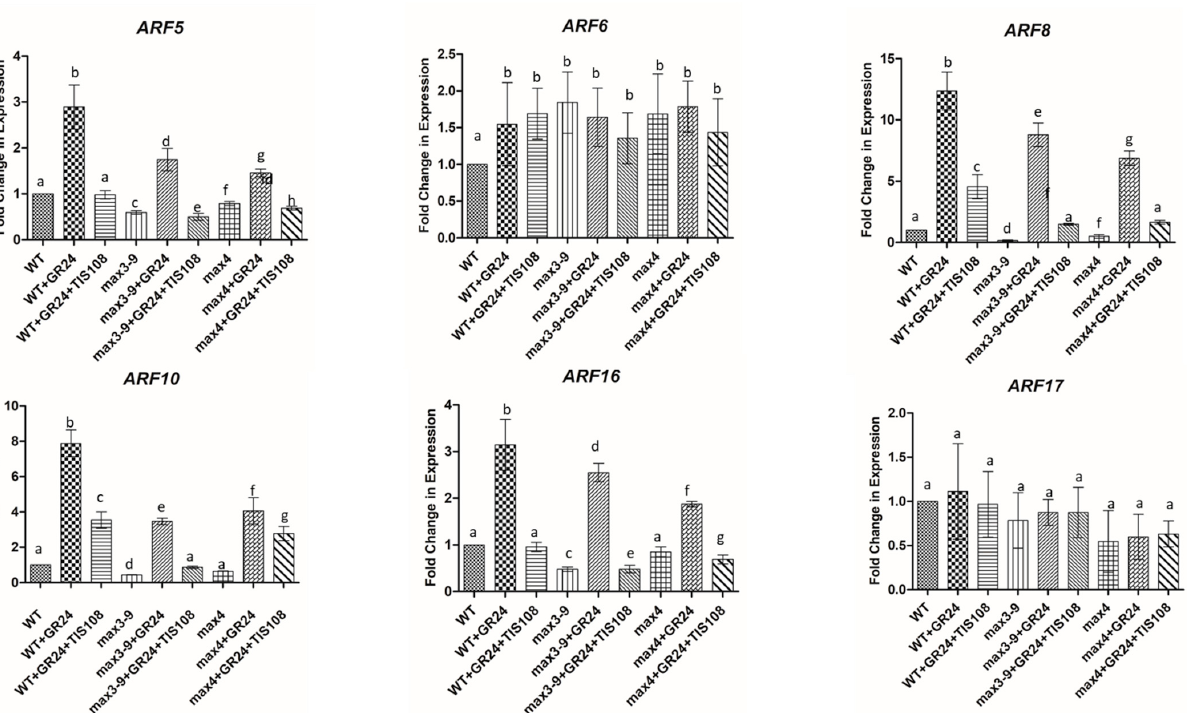
Figure 4. Fold change in expression level of ARF5, 6, 8, 10, 16, and 17 in WT, max3–9 , and max4 tissue after 7 days of induction. Tissue was also treated with GR24 (50 nM) and/or TIS108 (10 nM). Values are means ± SE of three biological replicates ( n = 15). Letters on bars indicate statistically significant differences ( p < 0.05).